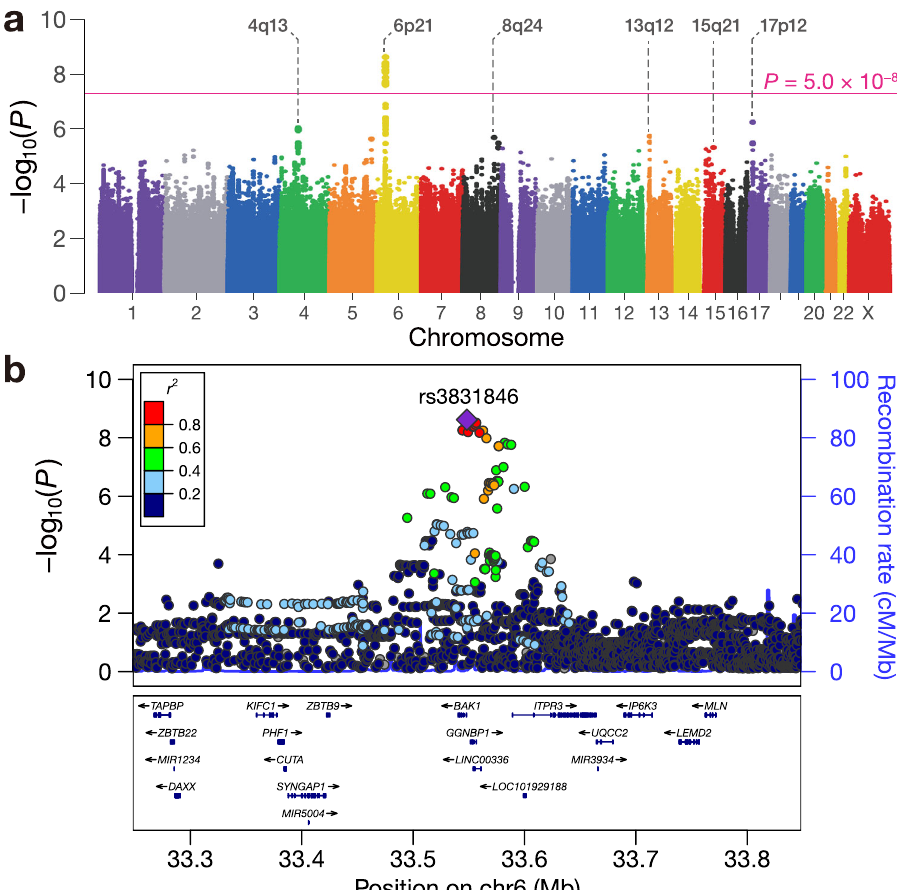
Fig. 1 | Genome-wide association study of intracranial germ cell tumors. a Genome-wide associations of imputed genetic variants are shown. The pink horizontal line indicates the genome-wide signi fi cance threshold of P =5.0 ×10 − 8 . The loci satisfying the suggestive signi fi cance threshold ( P =5.0×10 − 6 ) are annotated. b Regional associations of the imputed genetic